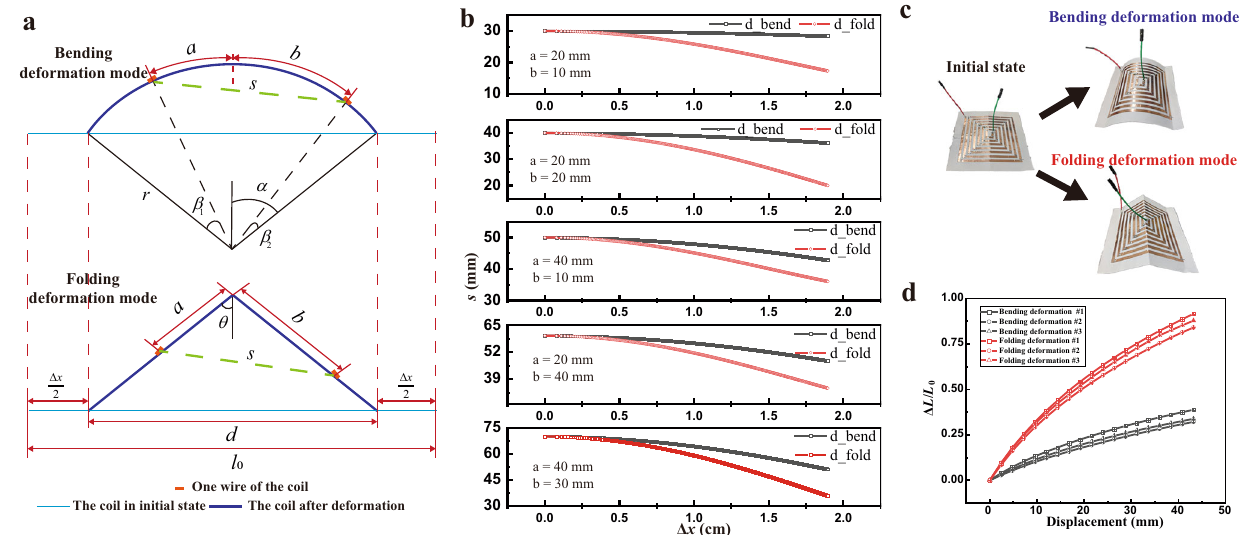
Fig. 4 Comparison of folding and bending deformation modes. a Section diagram and parameter meanings of bending and folding deformation modes. b Simulation results of position relationship under different wire spacing deformations. c PSIFS in bending and folding deformation modes. d Measurement results of the sensitivity in bending and folding